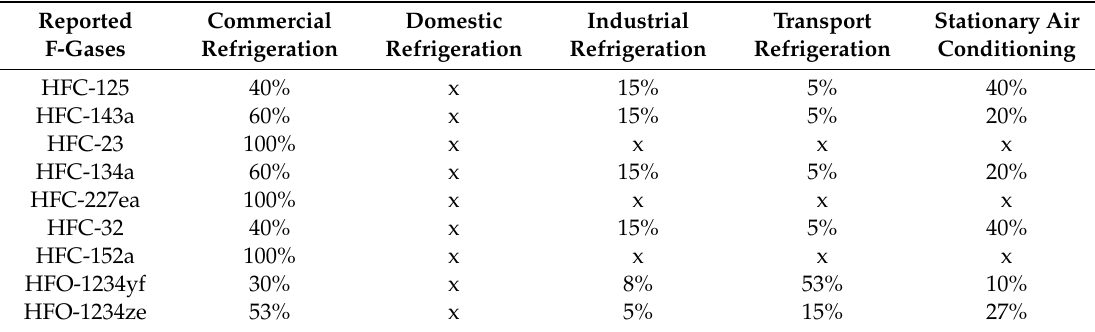
Table 4. Distribution of HFCs use by application area used for emission calculations in